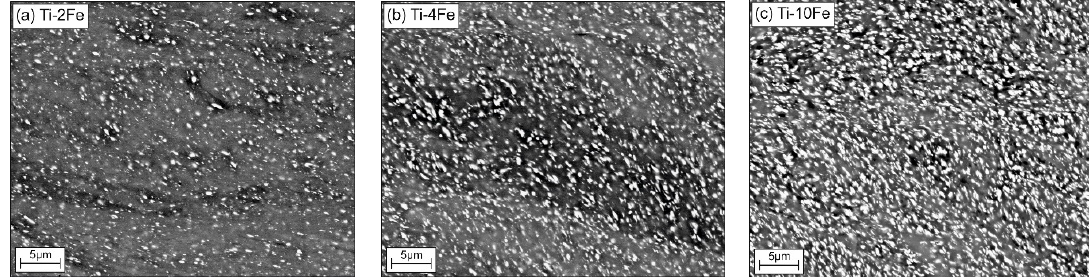
Figure 3. Microstructures of the high-pressure torsion (HPT) samples Ti-2Fe ( a ), Ti-4Fe ( b ), and Ti-10Fe ( c ) as seen by SEM/BSE. Prior to the HPT process, the samples were annealed at 470 °C for 4000 h. The white grains are TiFe, the gray areas correspond to the α -Ti and ω -Ti(Fe) phases. Table 2. Phase fractions (wt.%) in HPT-deformed samples, as determined using XRD. n α → ω = ω /( α + ω ) is the fraction of α -Ti, which transformed to ω -Ti(Fe). The errors of the XRD phase analysis (1 % to 3 %) were estimated based on the goodness of fit.